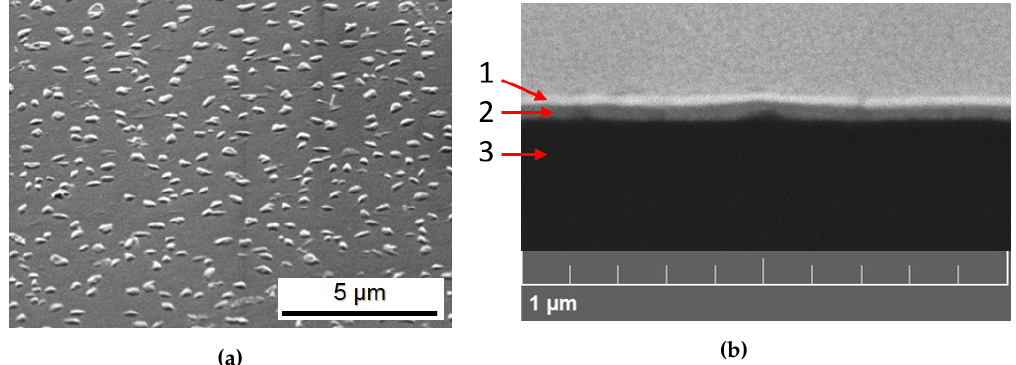
Figure 2. SEM images of a deposited CsPbBr 3 sample on glass. ( a ) Secondary Electrons micrograph. ( b ) Backscattered electrons micrograph of a sample cross section. Three layers are visible: the Pt coating (1), the 70 nm sputtered film (2), the glass substrate (3).